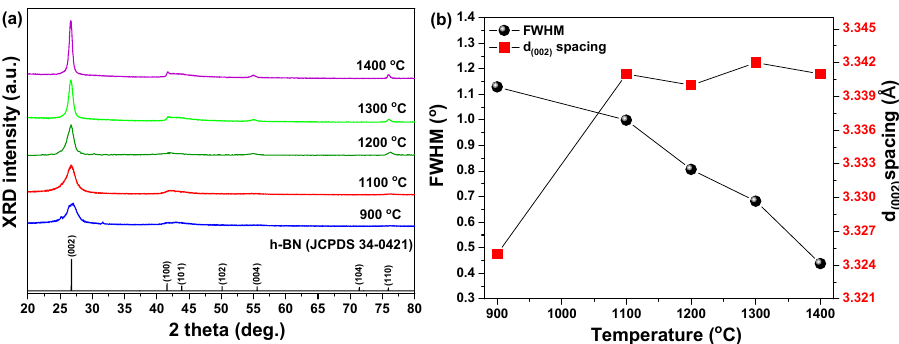
Figure 2. ( a ) X-ray powder diffraction (XRD) patterns, ( b ) full width at half maximum (FWHM) and interplanar spacing of (002) phase according to 900, 1100, 1200, 1300 and 1400 °C temperatures. Increased interplanar spacing and decreased FWHM of (002) peaks are commonly found during crystallization of h-BN [20]. We can see that the crystallinity of h-BN is improved with increased re-heating temperature. For these assumptions to be valid, Raman analysis expressed as the lattice frequency of an intrinsic constant was performed, and the results are shown in Figure 3. The Ce 3+ -doped h-BN nanophosphors’ position converts the E 2g mode near 1363 cm − 1 of Raman spectra to low frequencies. Because the frequency of the Raman spectrum mode is inversely proportional to the square root of the constituent atomic mass [21], the transition to the lower frequency of the Raman spectrum means that heavy Ce atoms are incorporated into the BN lattice of light elements.